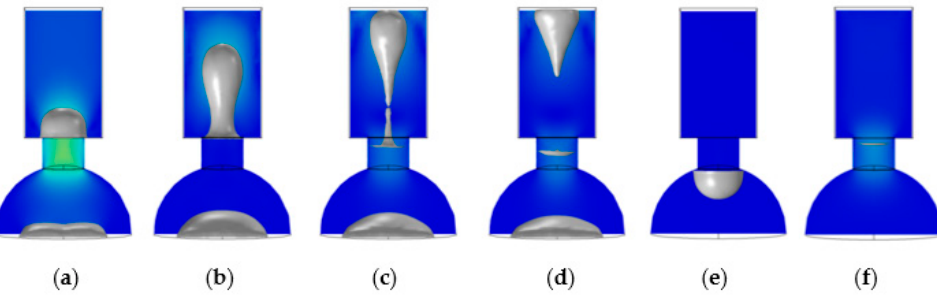
Figure 10. Inkjet process with the straight nozzle. ( a ) At 1 µ s, the nozzle began to squeeze out the liquid; ( b ) At 4 µ s, the liquid column formed; ( c ) At 6 µ s, the liquid column was broken, and the droplet was formed; ( d ) At 8 µ s, the droplet flew out from the air domain; ( e ) At 20 µ s, the bubble disappeared in the chamber; ( f ) At 46 µ s, the chamber was already filled.